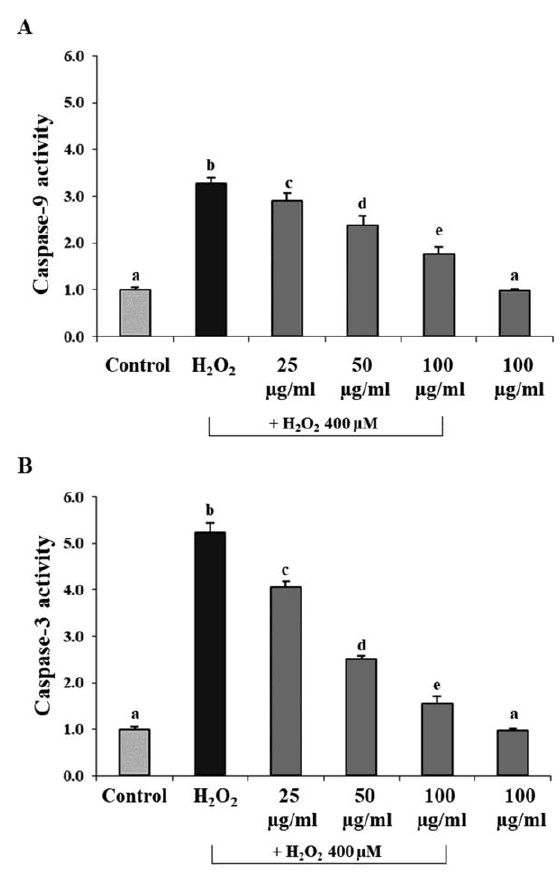
Figure 9. Effect of compound 3 on caspase-9 and caspase-3 activities in oxidative-stress-induced ARPE-19 cells. Cells were pre-treated with compound 3 at 25, 50 and 100 µg/mL for 24 h, followed by incubation with H 2 O 2 at 400 µM for 60 min. The treated cells were homogenized in a hypotonic buffer to obtain the part of the supernatant. The supernatant was determined on ( A ) caspase-9 and ( B ) caspase-3 activities. Results are presented as mean ± SD values ( n = 4). Different superscript letters (a – e) indicate significant differences between values in the column ( p < 0.05).